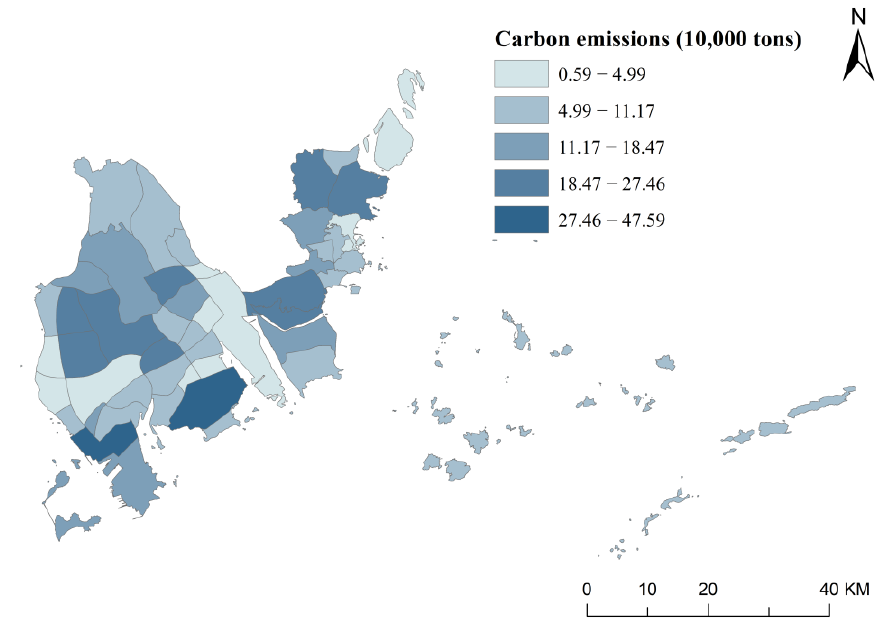
Figure 5. Spatial distribution of carbon emission index in Zhuhai. Table 6. Regression results of landscape spatial form and carbon emission in urban clusters.